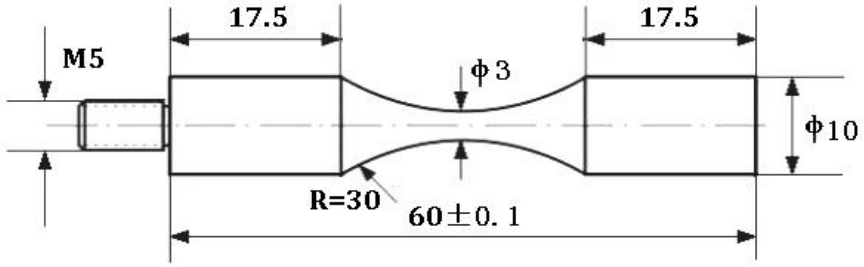
Figure 1. Dimension of the fatigue sample (all dimensions are in mm).